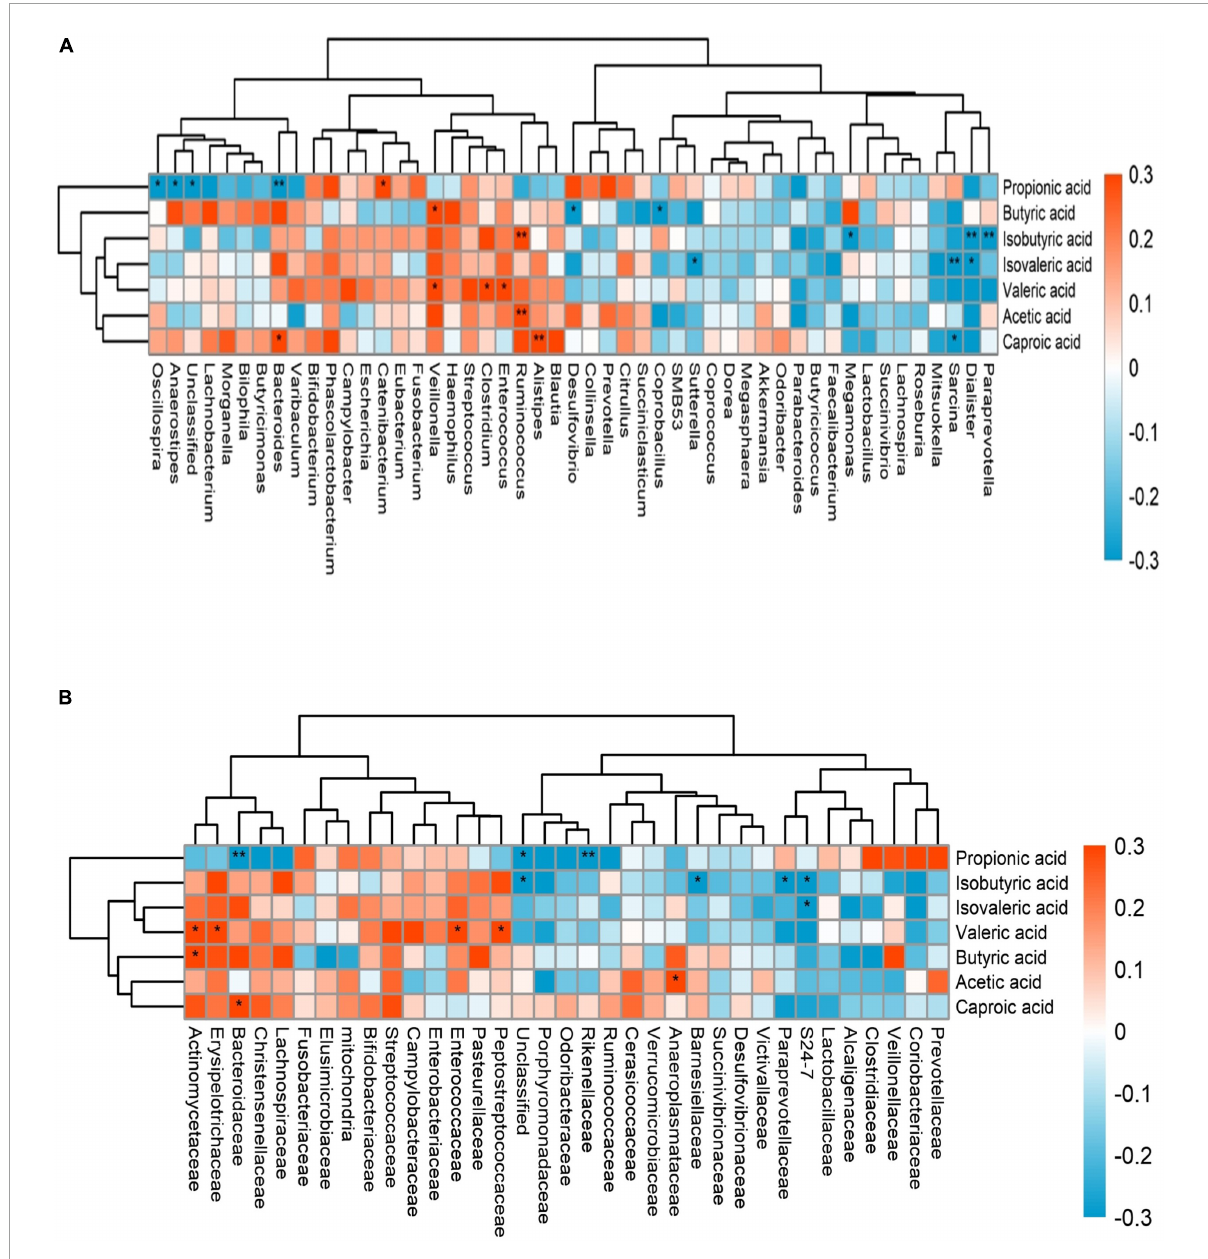
FIGURE3 The abscissa is the name of gut microbiota, and the ordinate is the name of short-chain fatty acids (SCFAs). Each square crossed by abscissa and ordinate represents the correlation and significance of the two. The size of the correlation coefficient is expressed by the difference and depth of color, red represents positive correlation, blue represents negative correlation, darker color, higher correlation, lighter color, lower correlation; *: 0.01 < p < 0.05; **: 0.001 < p < 0.01. (A) Showed the correlation between serum SCFAs and fecal flora at genus level, (B) showed the correlation between serum SCFAs and fecal flora at family